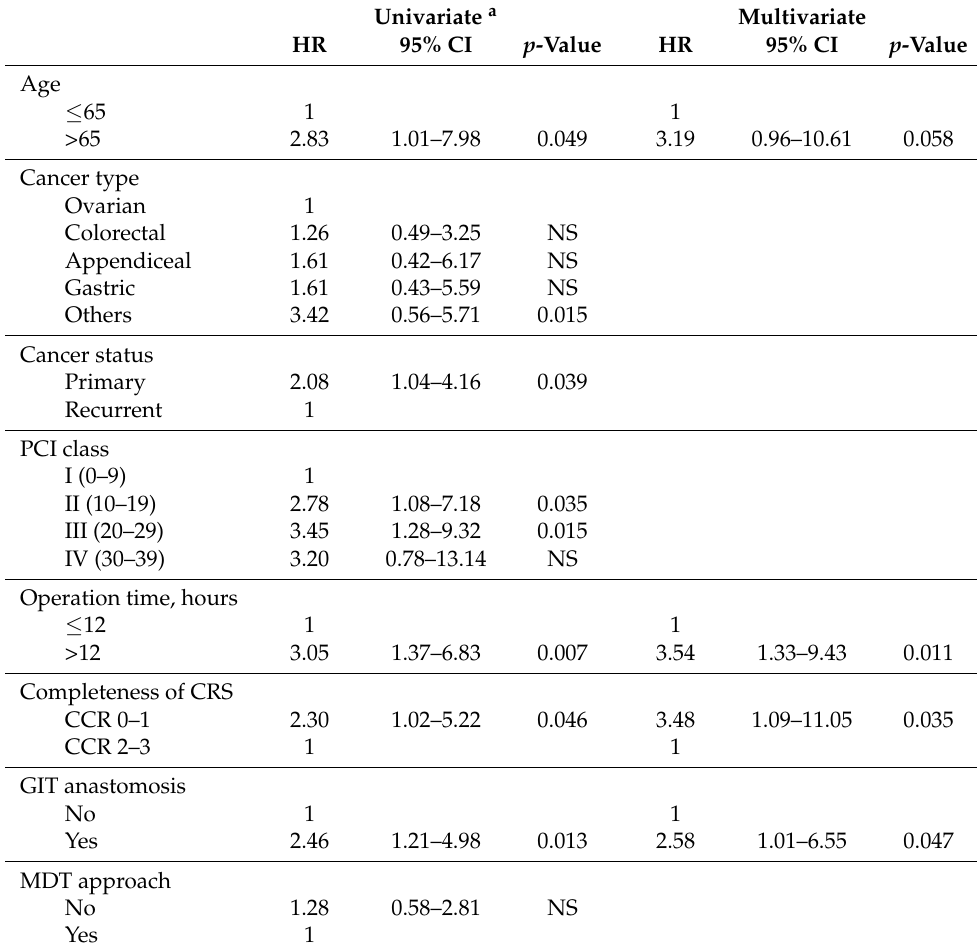
Table 4. Univariate and multivariate analyses of significantly predictive factors on appearance of post-operative complications for the patients after